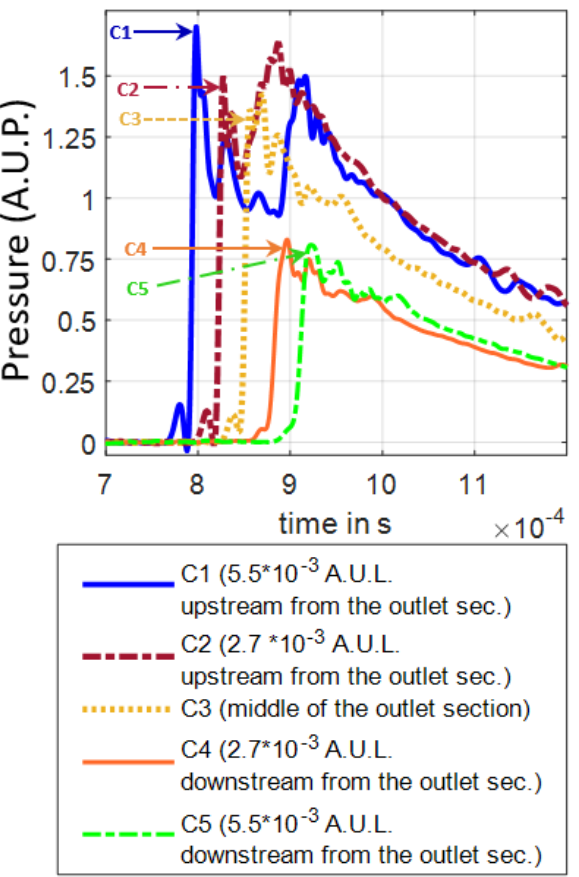
Figure 13. Pressure histories at several positions around the outlet